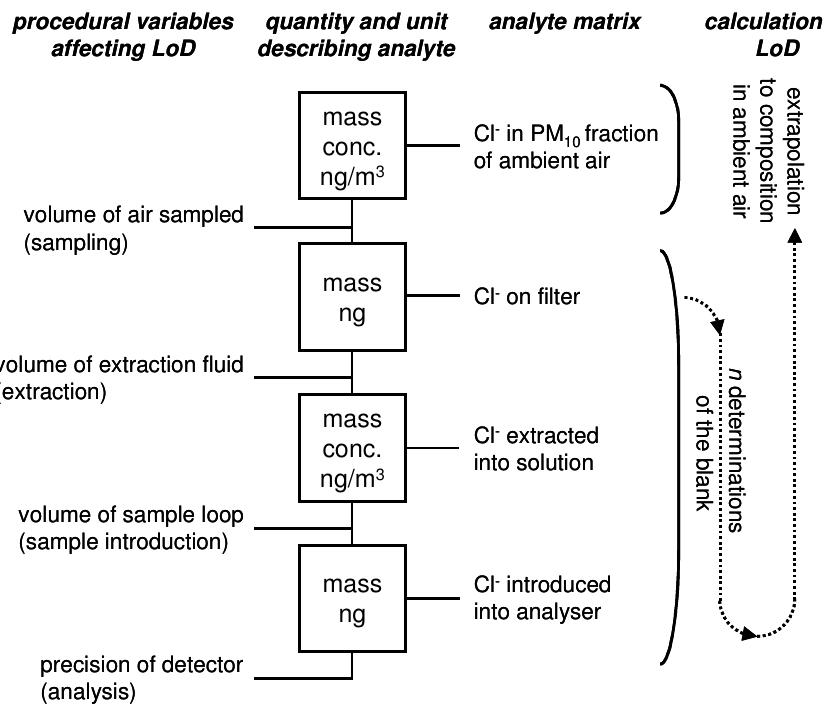
FIGURE 1. Diagrammatic representation of the procedural variables and the analytical method processes (in brackets) to which they apply (far left column), affecting the calculation and expression of the LoD for the analysis of the chloride content of the PM 10 particulate phase of ambient air, and their relationship to the quantity and unit describing the analyte (second left column) and its matrix (third left column) at each stage. A normal measurement process on a real sample would proceed from top to bottom. The column on the far right indicates the direction of flow of the procedure with respect to the determination of the LoD – first the variability of chloride content of the blank filter is measured n times to determine a standard deviation for this blank value and then this is expressed in terms of the composition of ambient air by dividing this value by the volume of air